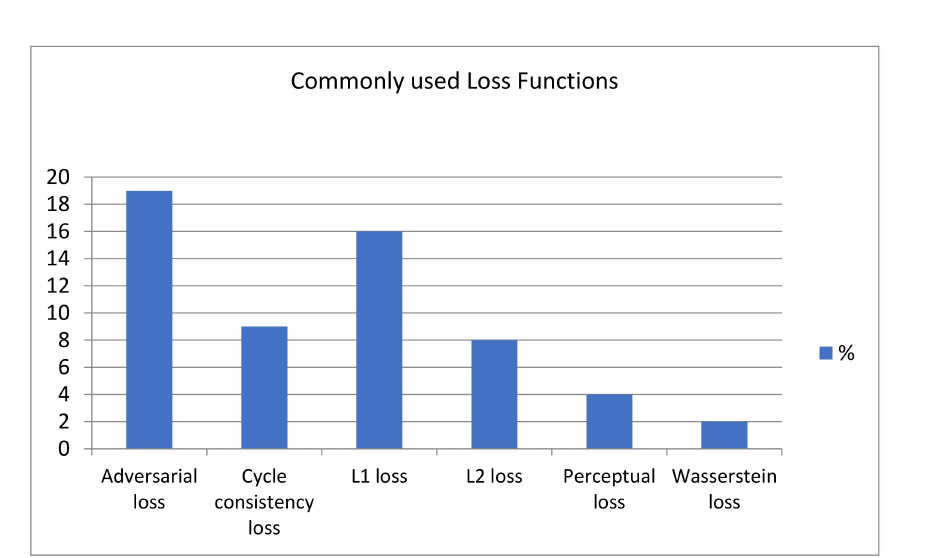
Figure 8. Distribution of commonly used loss functions in the